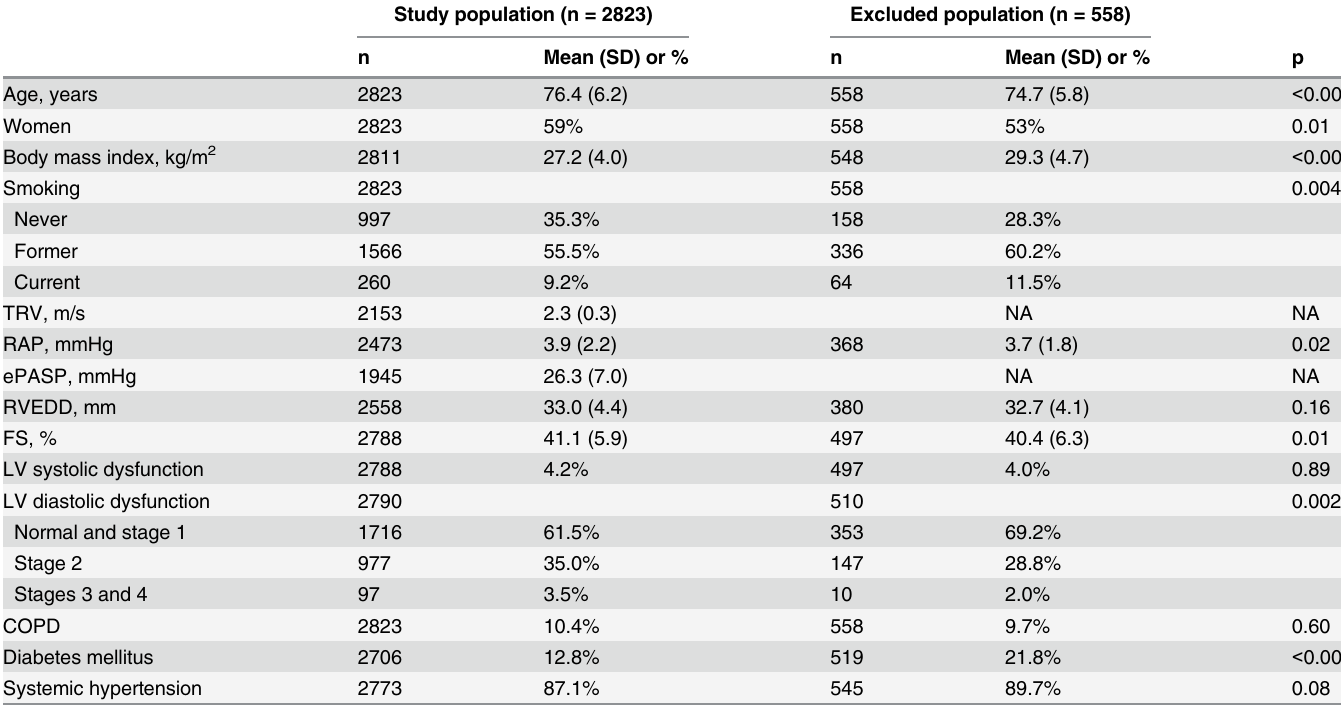
Table 1. Participant